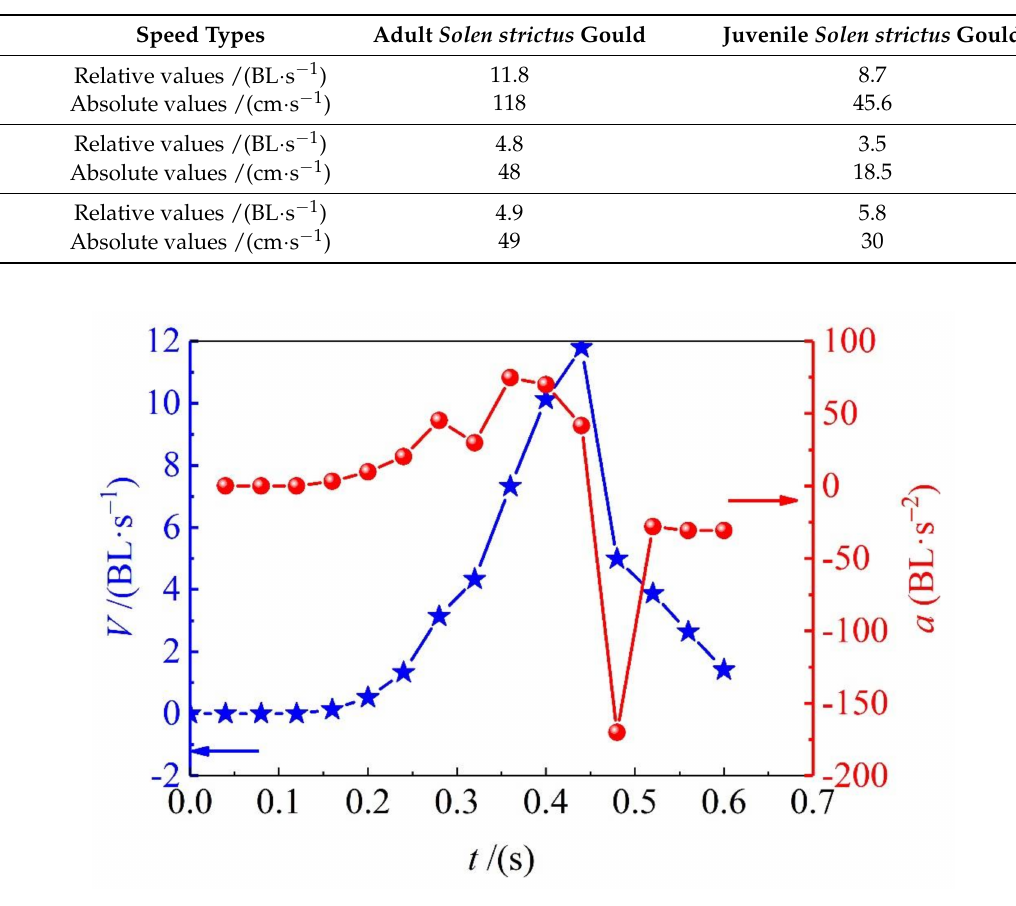
Figure 3. Sprint speed and acceleration of adult Solen strictus